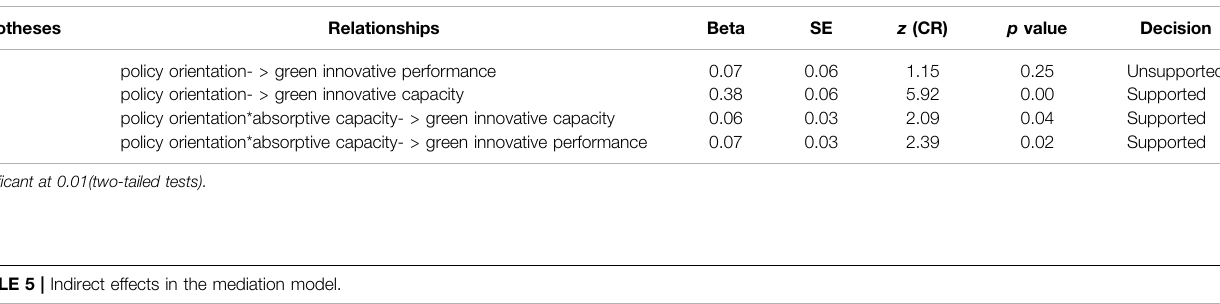
TABLE 4 | Results of structural model analysis.